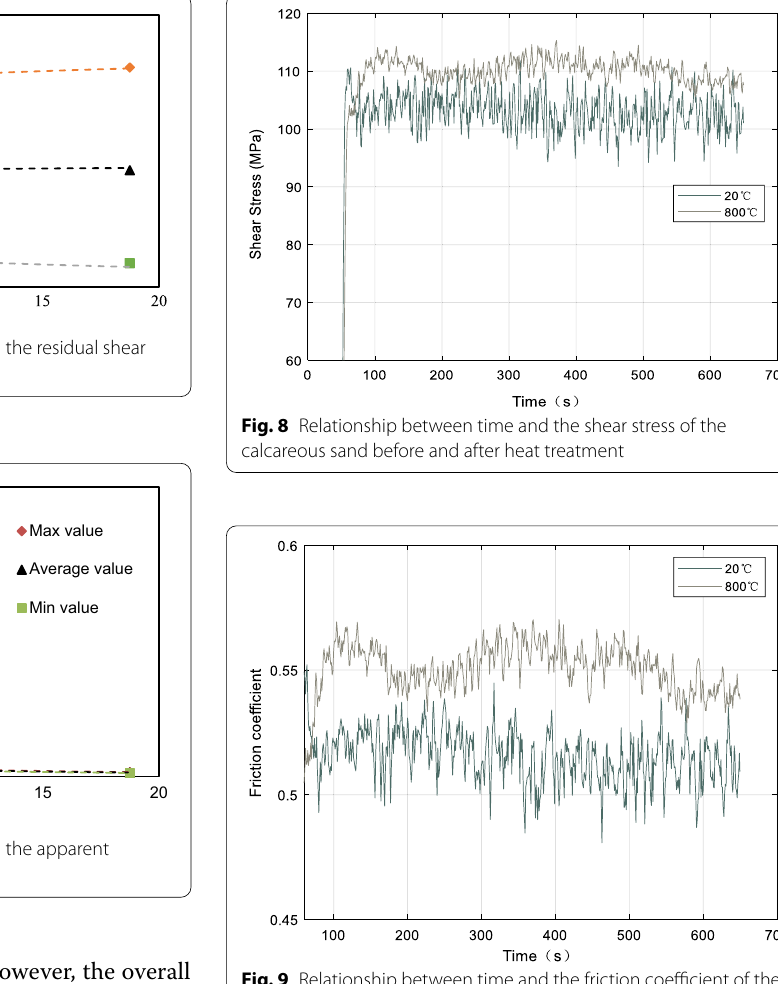
Fig. 9 Relationship between time and the friction coefficient of the calcareous sand before and after heat